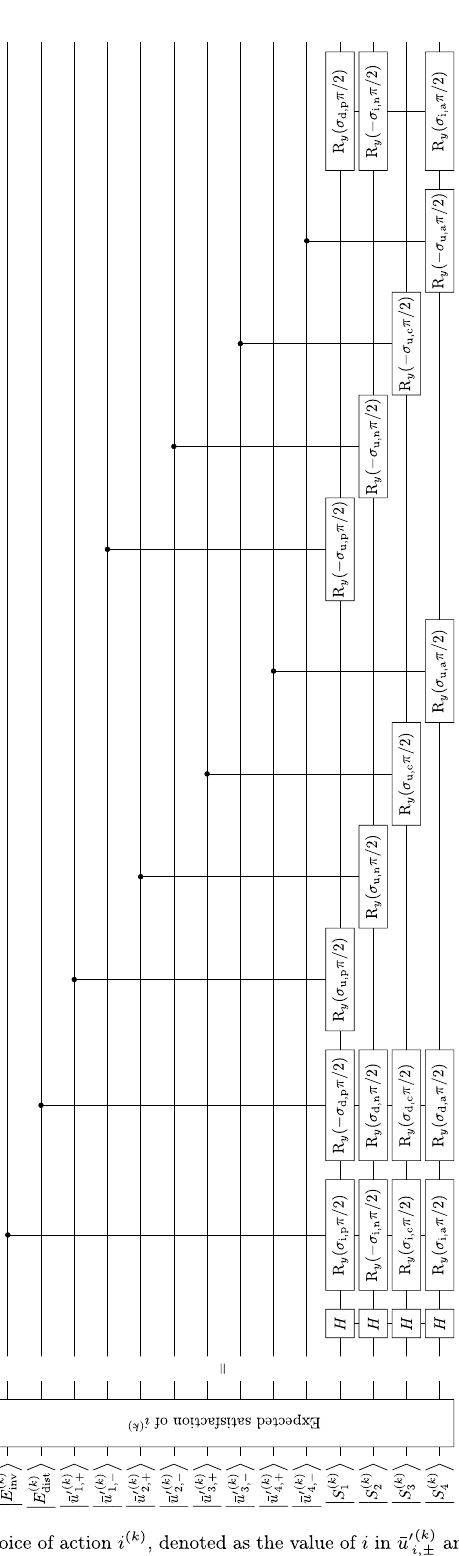
Figure 11. Extract quantum algorithm for satisfaction evaluation and decision-making (choice of